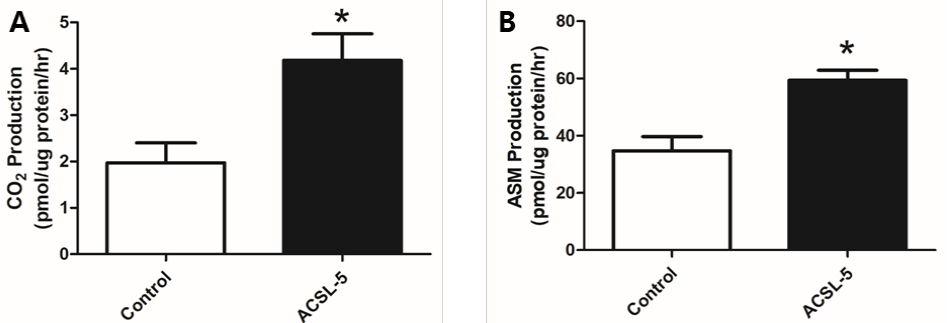
Figure 2. Effect of ACSL-5 overexpression on fatty acid oxidation. Fatty acid oxidation was measured using 14 C-labeled radioactivity of CO 2 ( A ) and ASM ( B ) via liquid scintillation counting (open bar, control cells; closed bar, ACSL-5 transfected cells). Palmitate complete oxidation (CO 2 producton) was approximately 2-fold higher in the ACSL-5 transfected group compared with the GFP-only transfected control (A). Similarly, palmitate incomplete oxidation (ASM production) was significantly increased by ACSL-5 overexpression (B). Data are expressed as presented as mean ± SEM (n = 6). * p < 0.05 versus control.